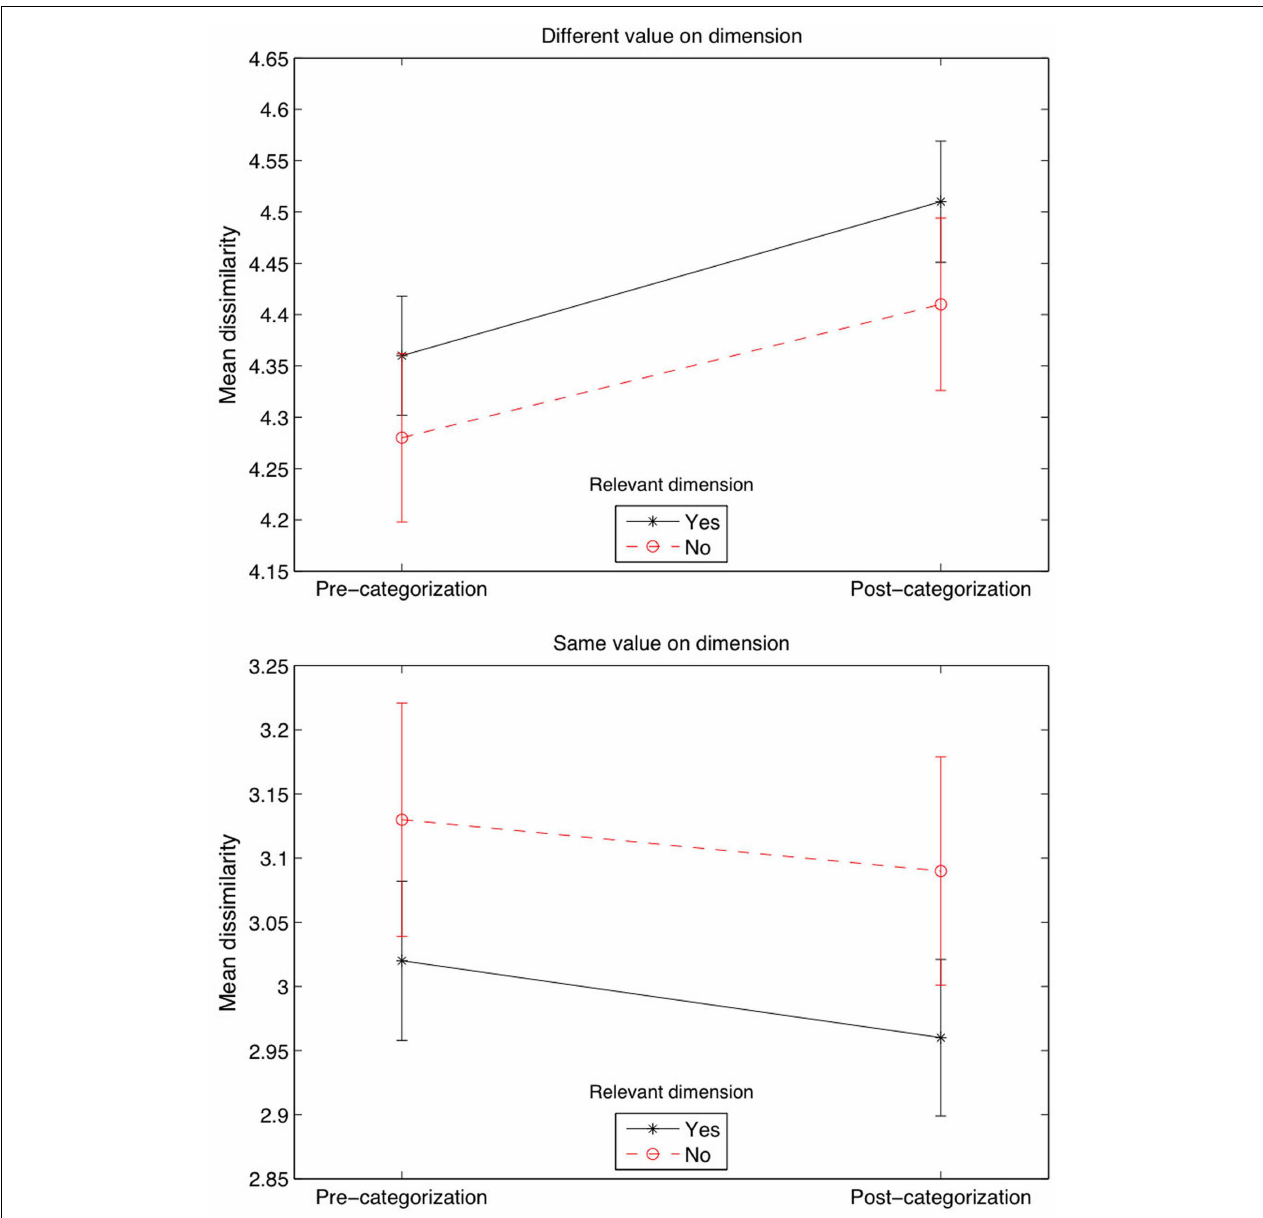
FIGURE 5 | Mean dissimilarity ratings across all trials. Error bars are ± 1 SEM.